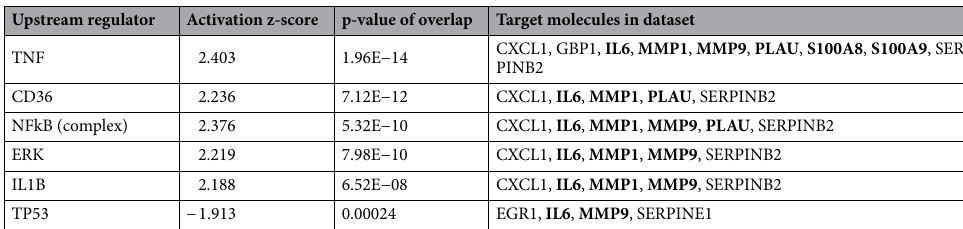
Table 4. Upstream regulators identified from intersection between public data and NGS experimental data under PM exposure. Bold texts indicate the hub genes consonant with Fig. 5.